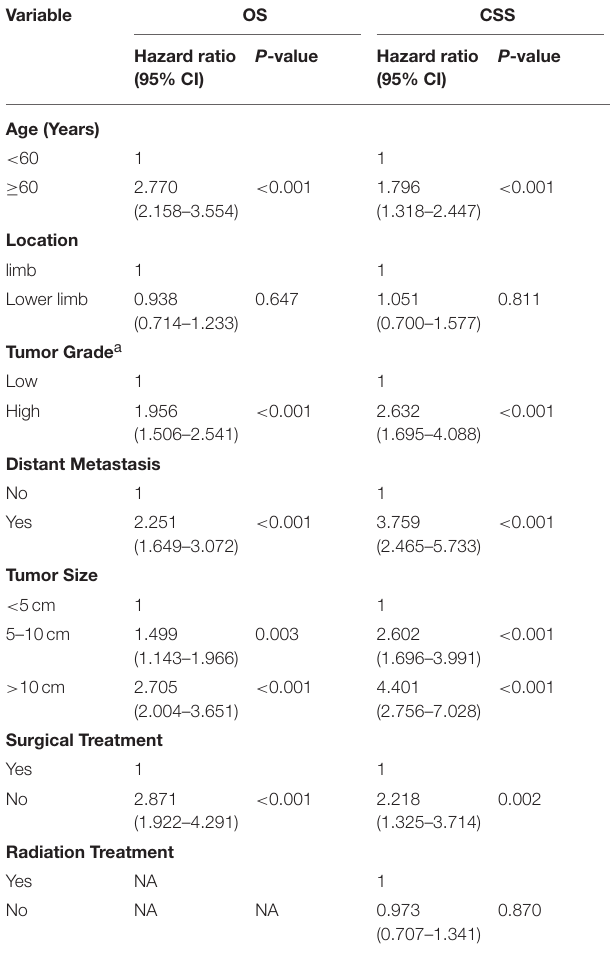
TABLE 2 | Univariate analysis of OS and CSS in the training cohort. Category